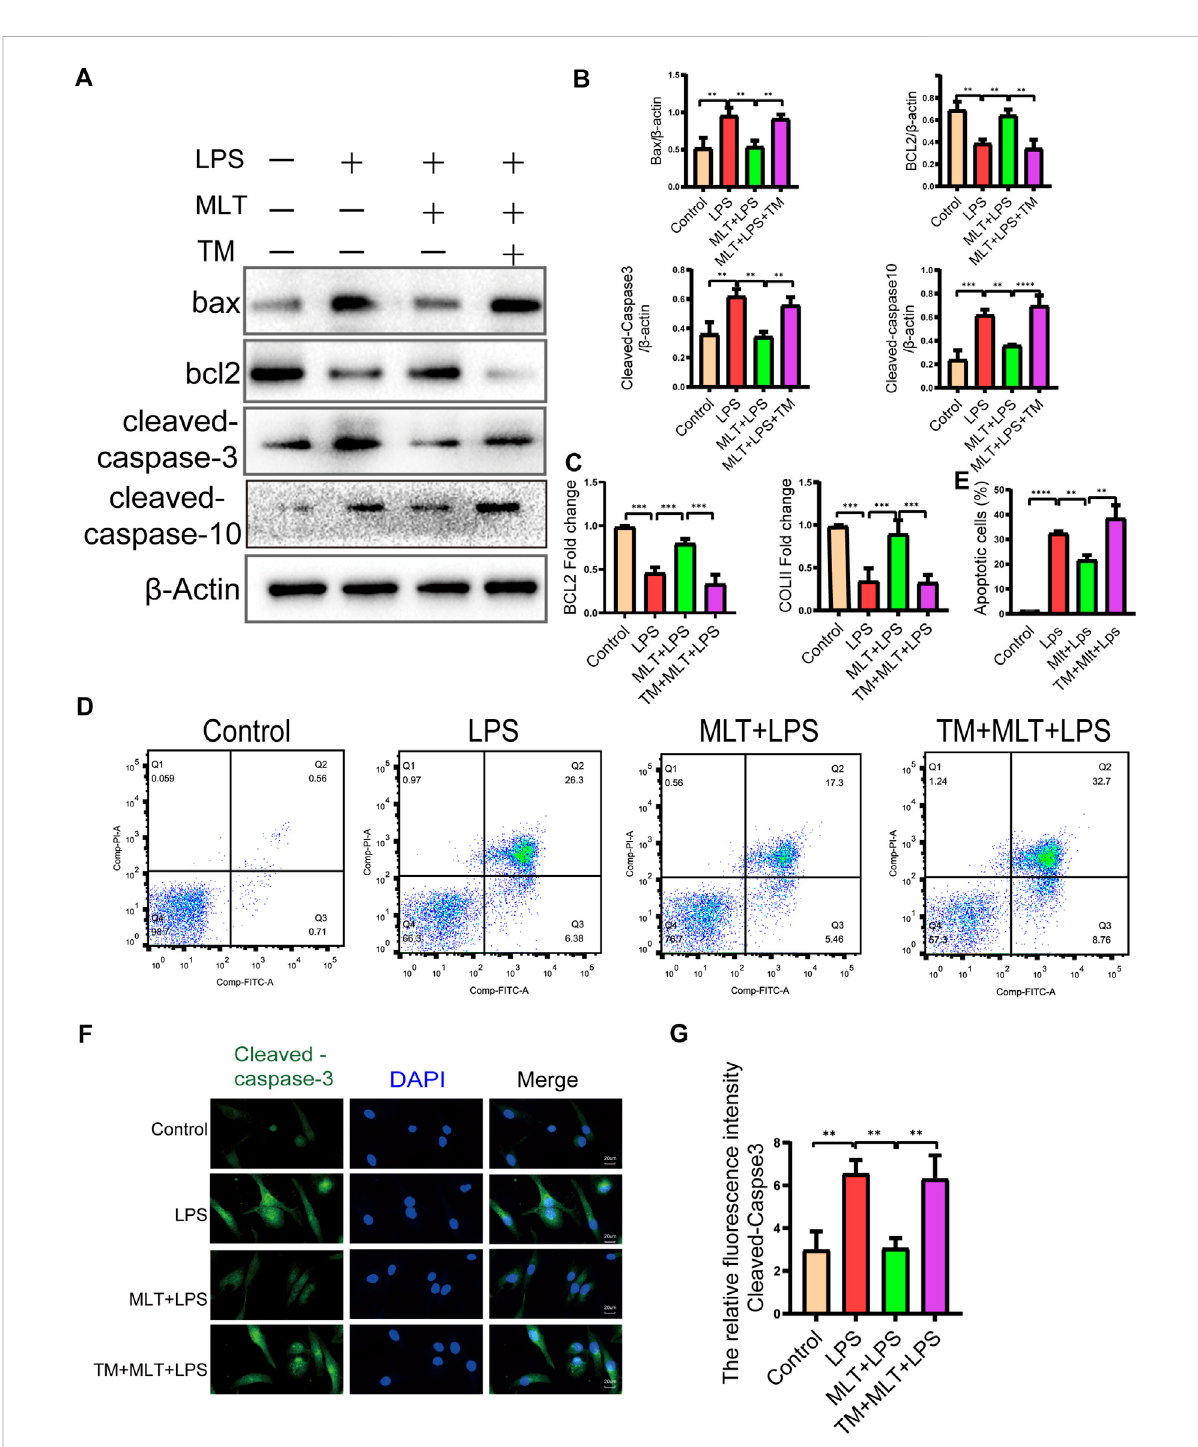
FIGURE 2 Melatonininhibitedapoptosisinhumanchondrocytesstimulatedbylipopolysaccharide(LPS). (A,B) WedetectedtheproteinlevelsofBcl – 2,Bax cleaved caspase-10 and cleaved caspase – 3 in each group. (C) mRNA expression levels of collagen II and Bcl – 2 in each group were measured using qRT – PCR (D – E) Apoptosisofhumanchondrocytesweredeterminedby fl owcytometryfollowingannexinV-PEandpropidiumiodidestaining. (F,G) Quanti fi cation of the intensity ofcleavedcaspase – 3 inhuman chondrocytesin each group was performed with immuno fl uorescence staining. Theexperimentwasrepeatedthreetimesindependently.Allvaluesareshownasmean±standarddeviation.** p < 0.01,*** p < 0.001,**** p <